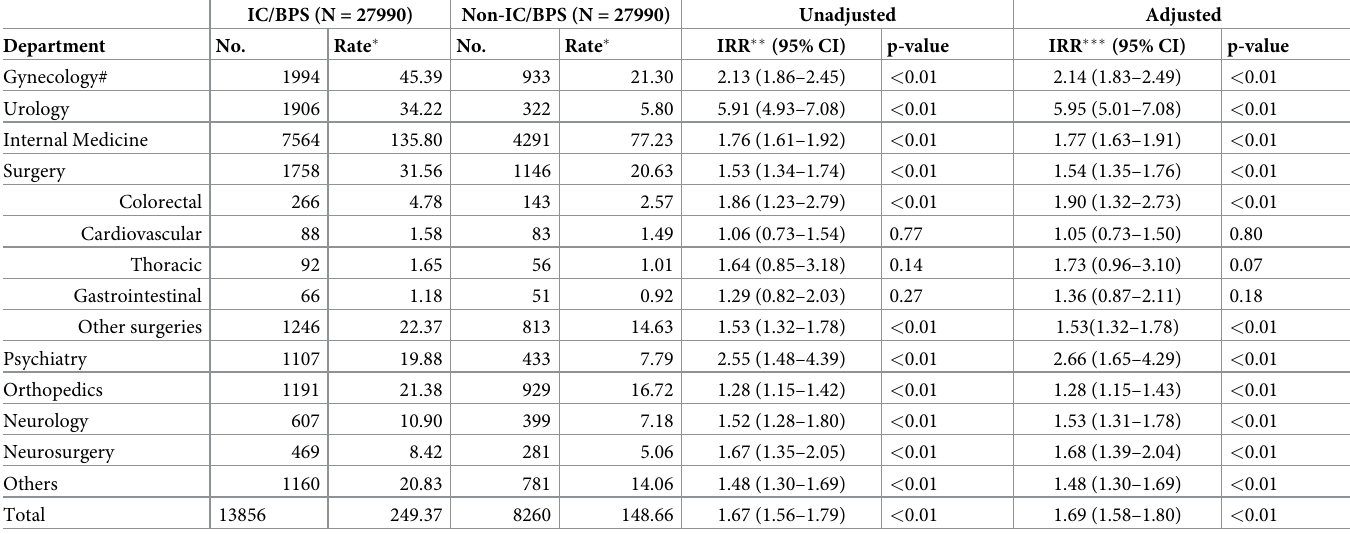
Table 4. Incidence rate ratio of hospitalizations between IC/BPS and non-IC/BPS